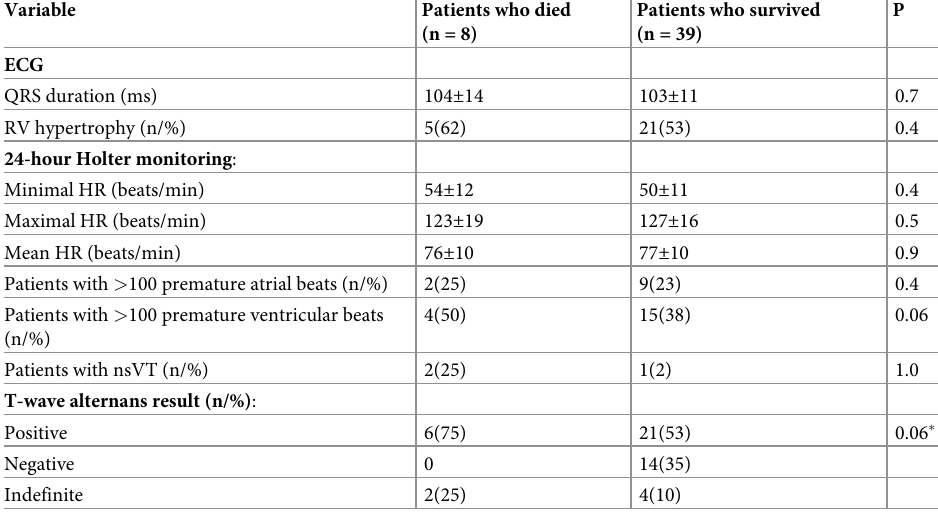
ECG–electrocardiogram; HR–heart rate, RV–right ventricle, nsVT–non-sustained ventricular tachycardia. (cid:3) Fisher’s